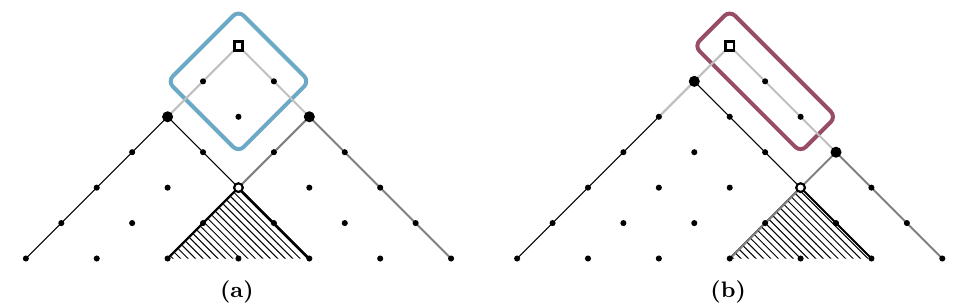
Figure 10. Nested modules of the (a) leading and (b) subleading soft